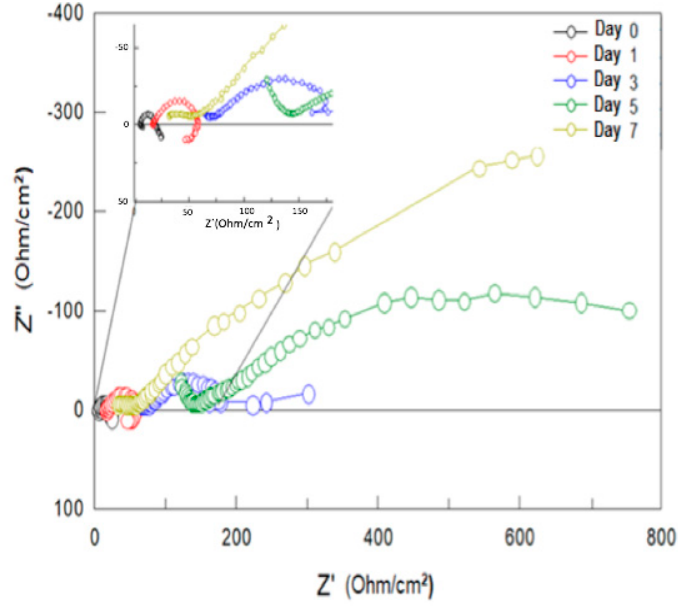
Figure 10. Nyquist diagrams for Mg ‐ 1Cr anode for 0, 1, 3, 5, and 7 days of immersion in seawater.